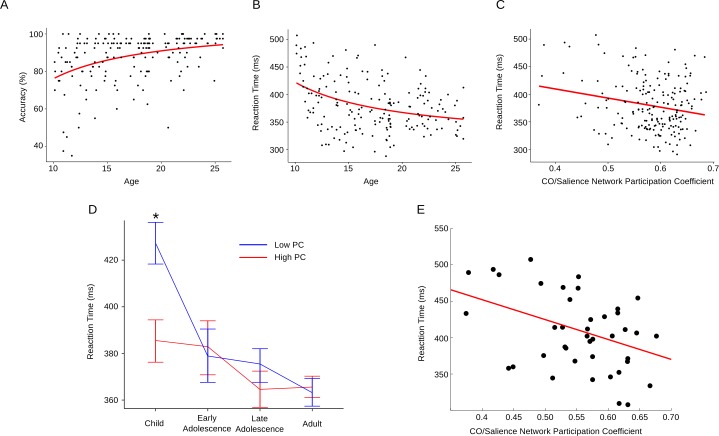
Relationship between increased cingulo-opercular/salience network integration and cognitive control.Performance on the antisaccade task improves throughout adolescence, evidenced by increased accuracy (A) and decreased reaction time (B). As integration of the CO/Salience network increases, reaction time significantly decreases (C). (D) Results from the moderation analysis. CO/Salience integration significantly moderated the effect between age and antisaccade reaction time, such that less CO/Salience integration was predictive of longer reaction times, while higher CO/Salience integration led to significantly faster reaction times (p < 0.001). Note that this effect only occurred during late childhood, indicating that earlier maturation of the CO/Salience network is critical for achieving adult-like behavior earlier in development. (E) Reaction time as a function of CO/Salience network integration in the child group. (Data available from sheet “Fig5Fig6” in S1 Data.)